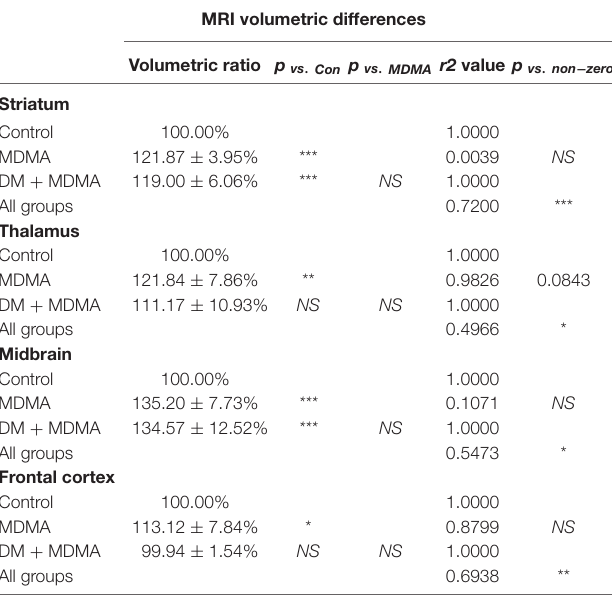
TABLE 3 | MRI volumetric